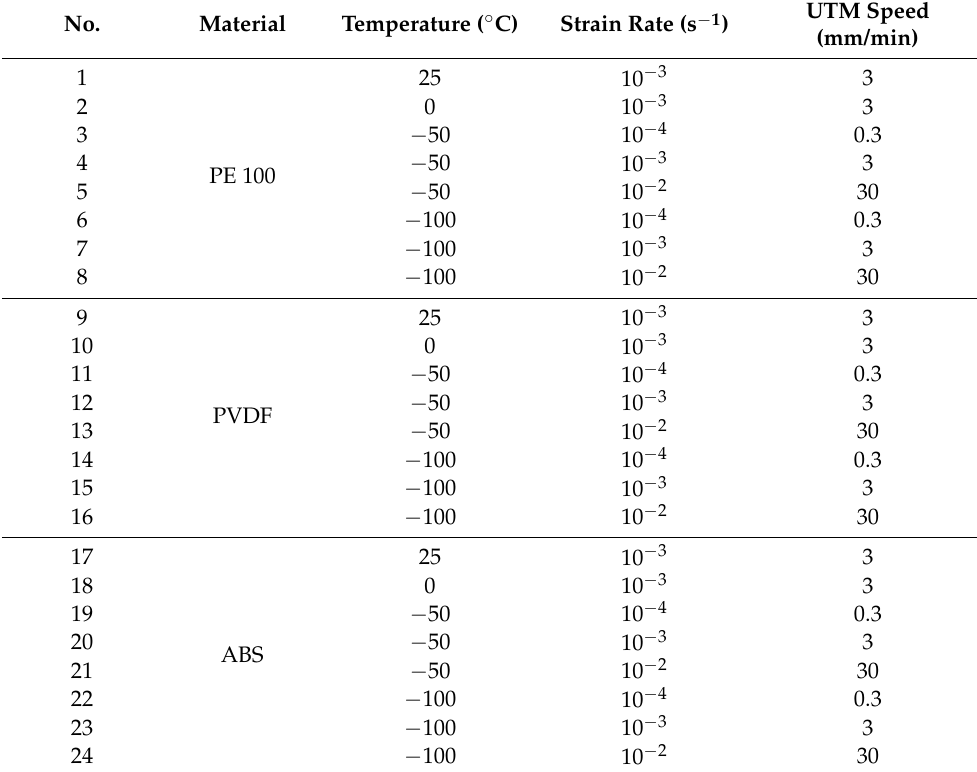
Table 1. Low-temperature considered test scenarios of the three kinds of polymer samples.